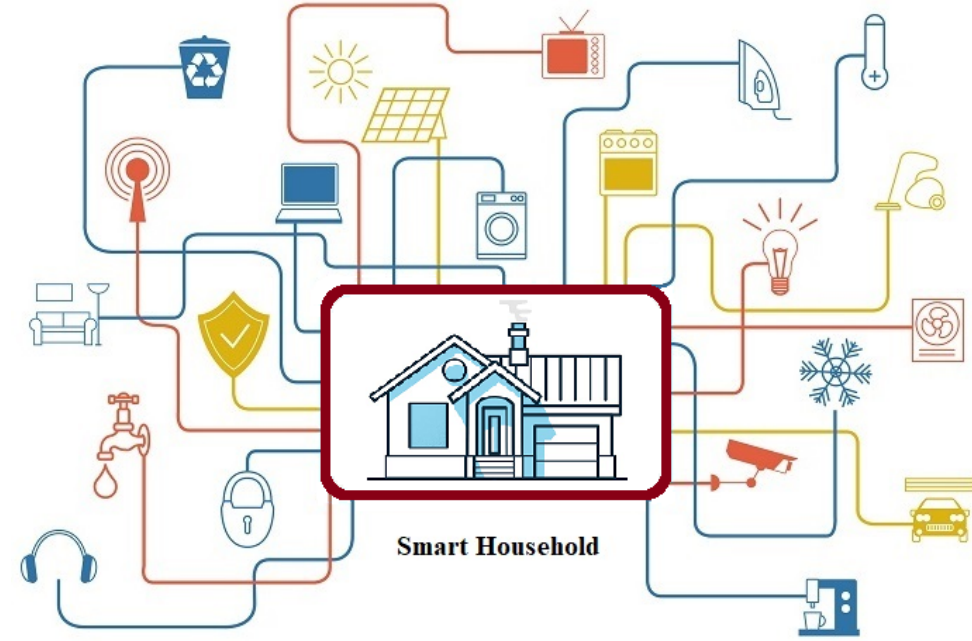
Figure 1. Smart household with potential power consumption